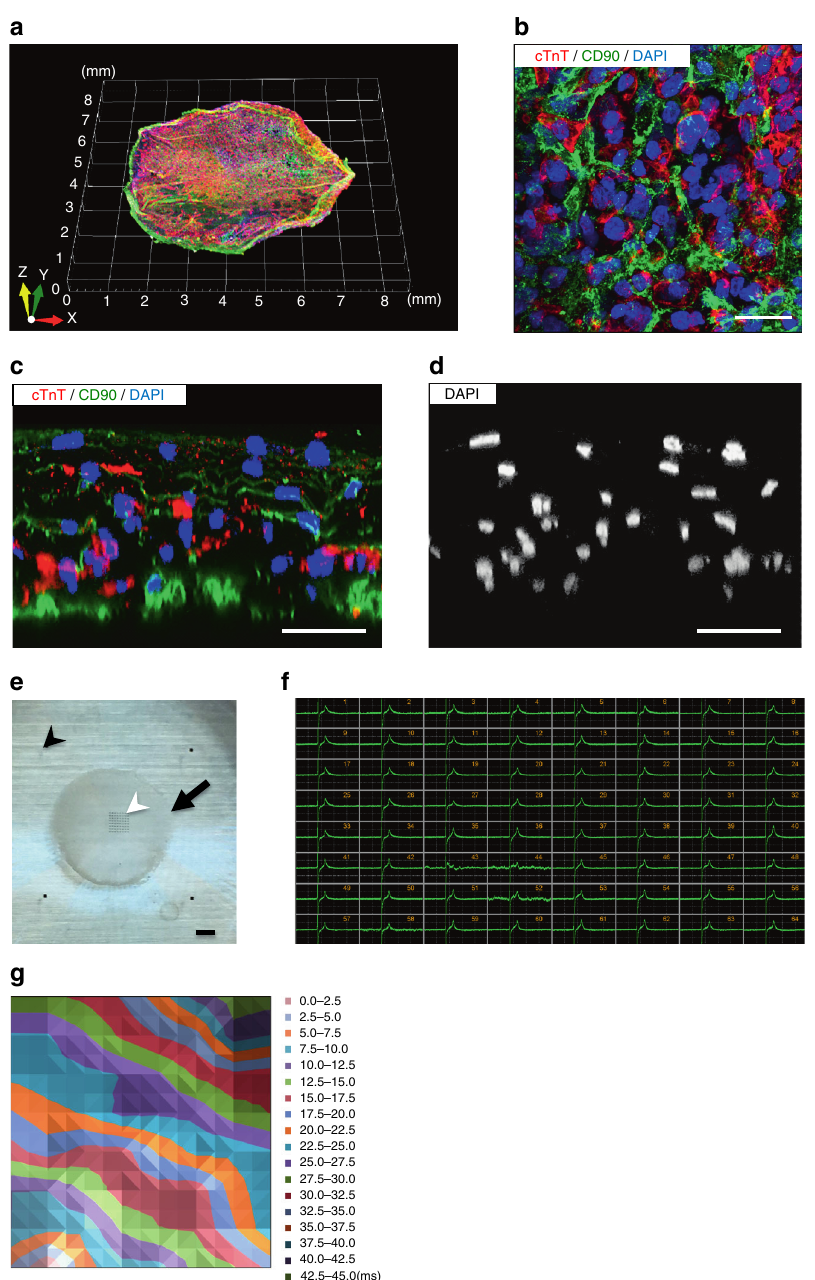
Fig. 1 Characterization of heterogeneous 3D cardiac tissue sheets (CTSs). a Representative confocal microscopic image of a whole CTS that was immunostained for cTnT (cardiomyocytes, red), CD90 (mesenchymal cells, green), and DAPI (nuclei, blue). b High-magni fi cation image of a horizontal cross-section (see Supplementary Movie 1). cTnT (red), CD90 (green), and DAPI (blue). c Confocal immunostaining of a vertical cross-section. cTnT (red), CD90 (green), and DAPI (blue). d Confocal immunostaining of a vertical cross-section. DAPI (white). e Macroscopic appearance of a CTS set on a multi-electrode array probe. Arrow: CTS. Black arrowhead: a reference electrode (four reference electrodes in total). White arrowhead: main electrodes (multi-electrode array). f Representative EFP waveforms obtained from each electrode. g Representative electrical propagation map. Propagation from the lower left corner towards the upper right direction. cTnT, cardiac troponin-T; DAPI, 4 ′ ,6-diamidino-2-phenylindole. Scale bars: 25 μ m in b , 50 μ m in c , d , and 1 mm in